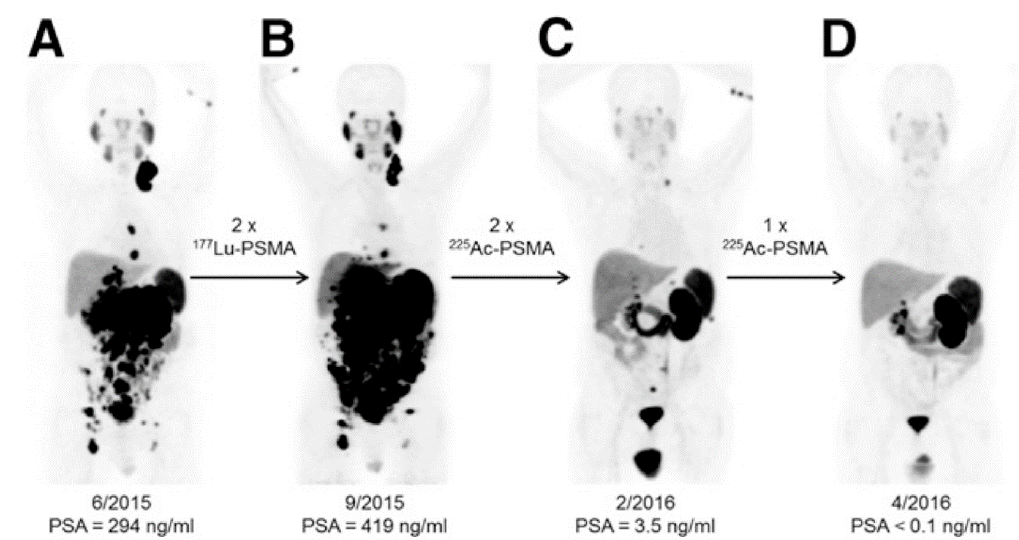
Figure 7. [ 68 Ga]Ga-PSMA-11 PET/CT scans of a patient with castration-resistant prostate cancer (CRPC). ( A ) Initial tumor burden ( B ) Progression despite 2 cycles of β − -emitting [ 177 Lu]Lu-PSMA-617 ( C , D ) Impressive decrease in tumor burden after two cycles of α -emitting [ 225 Ac]Ac-PSMA-617. Reproduced from [6], Frontiers.